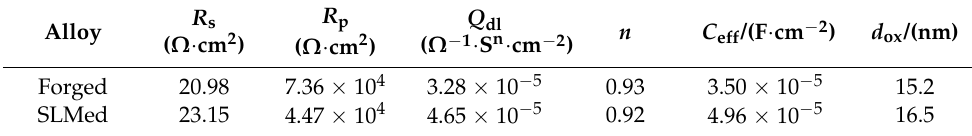
Figure 6. Electrical equal circuit for fitting EIS. Table 2. The fitted EIS data of the forged and SLMed Ti-6Al-4V alloys.